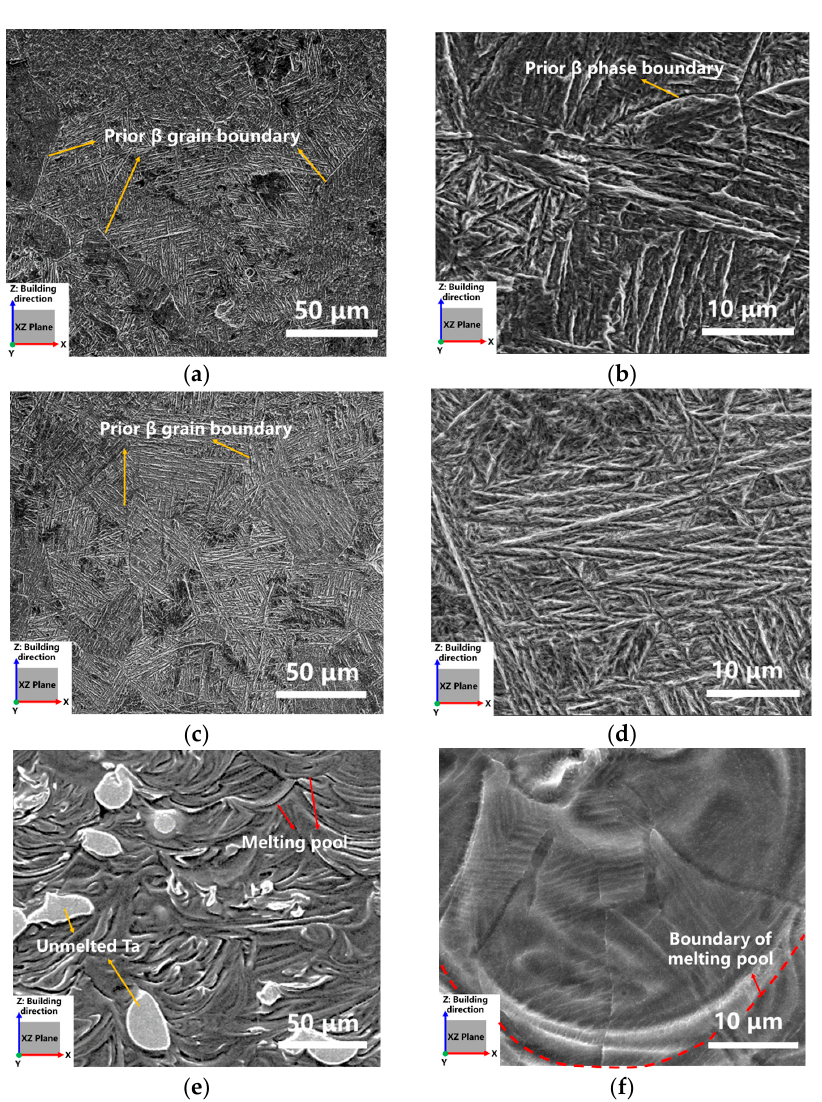
Figure 12. SEM images of LPBF Ti ‐ Ta samples at various building parameters: ( a , b ) S1 (v = 120 mm/s, E = 694 J/mm 3 ), ( c , d ) S2 (v = 220 mm/s, E = 381 J/mm 3 ), and ( e , f ) S3. (v = 1100 mm/s, E = 76 J/mm 3 ).